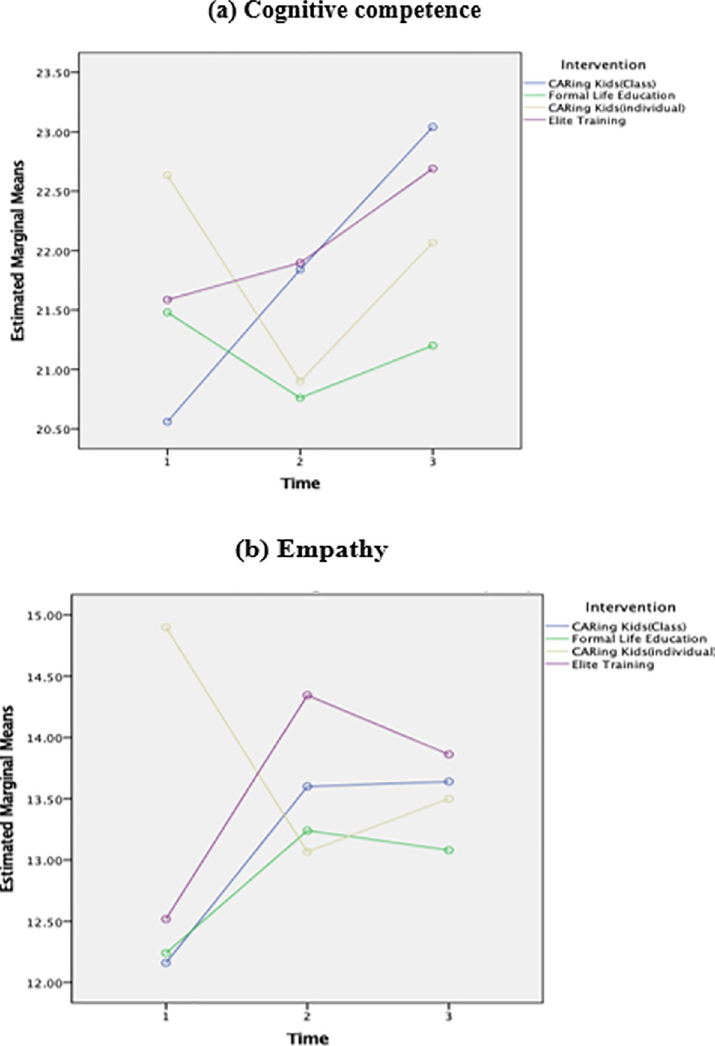
Fig 3. Comparison of the mean scores of socio-emotional competences among different interventions in different time points (a and b).